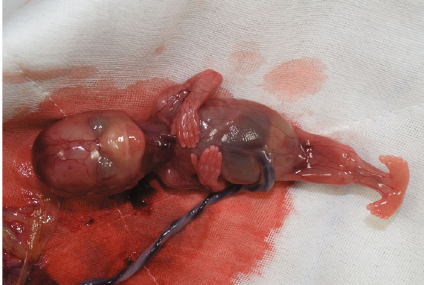
Figure 4: Macroscopic image of the delivered baby. A fused single lower extremity was